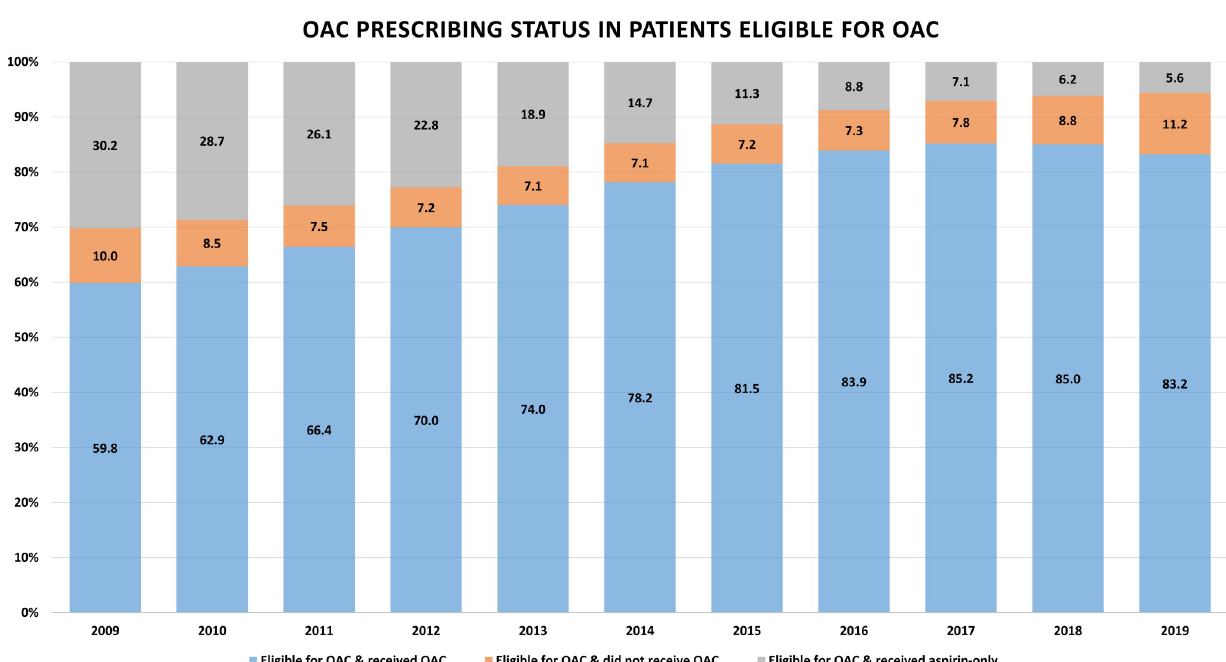
Fig 4. Proportions of patients prescribed OACs (VKA or NOAC), aspirin only, or no treatment for patients eligible for OAC. NOAC, non- vitamin K antagonist oral anticoagulant; OAC, oral anticoagulant; VKA, vitamin K antagonist.